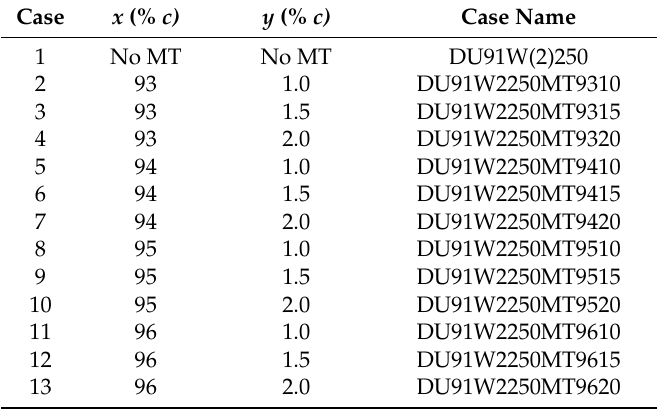
Table 3. MT cases and